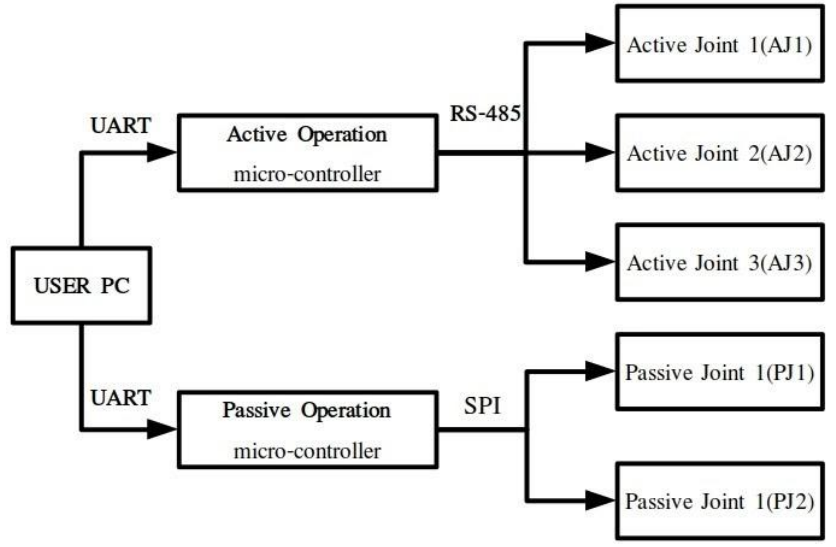
Figure 4. SMM system architecture.